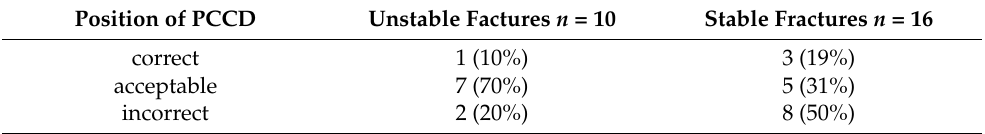
Table 3. PCCD positioning.